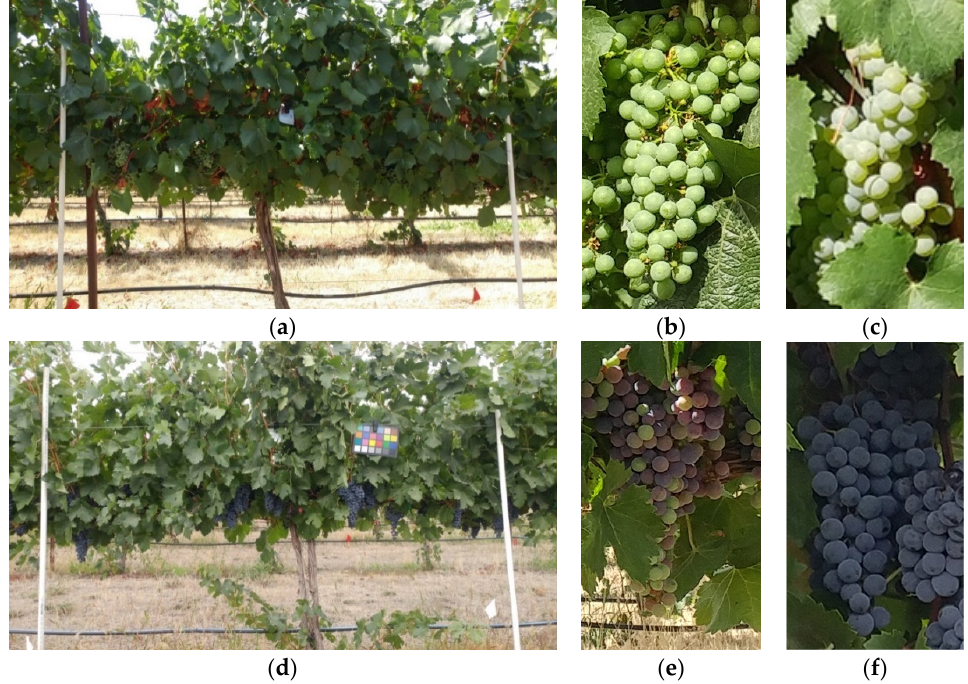
Figure 1. Grape dataset acquisition on ( a ) Chardonnay (white color of berry skin when mature; 10– 33 grape bunches per plant) with the close-up views of grape bunch during ( b ) immature and ( c ) mature stages, and ( d ) Merlot (red color of berry skin when mature; 12–32 grape bunches per plant) with the close-up views of grape bunch during ( e ) immature and ( f ) mature stages.